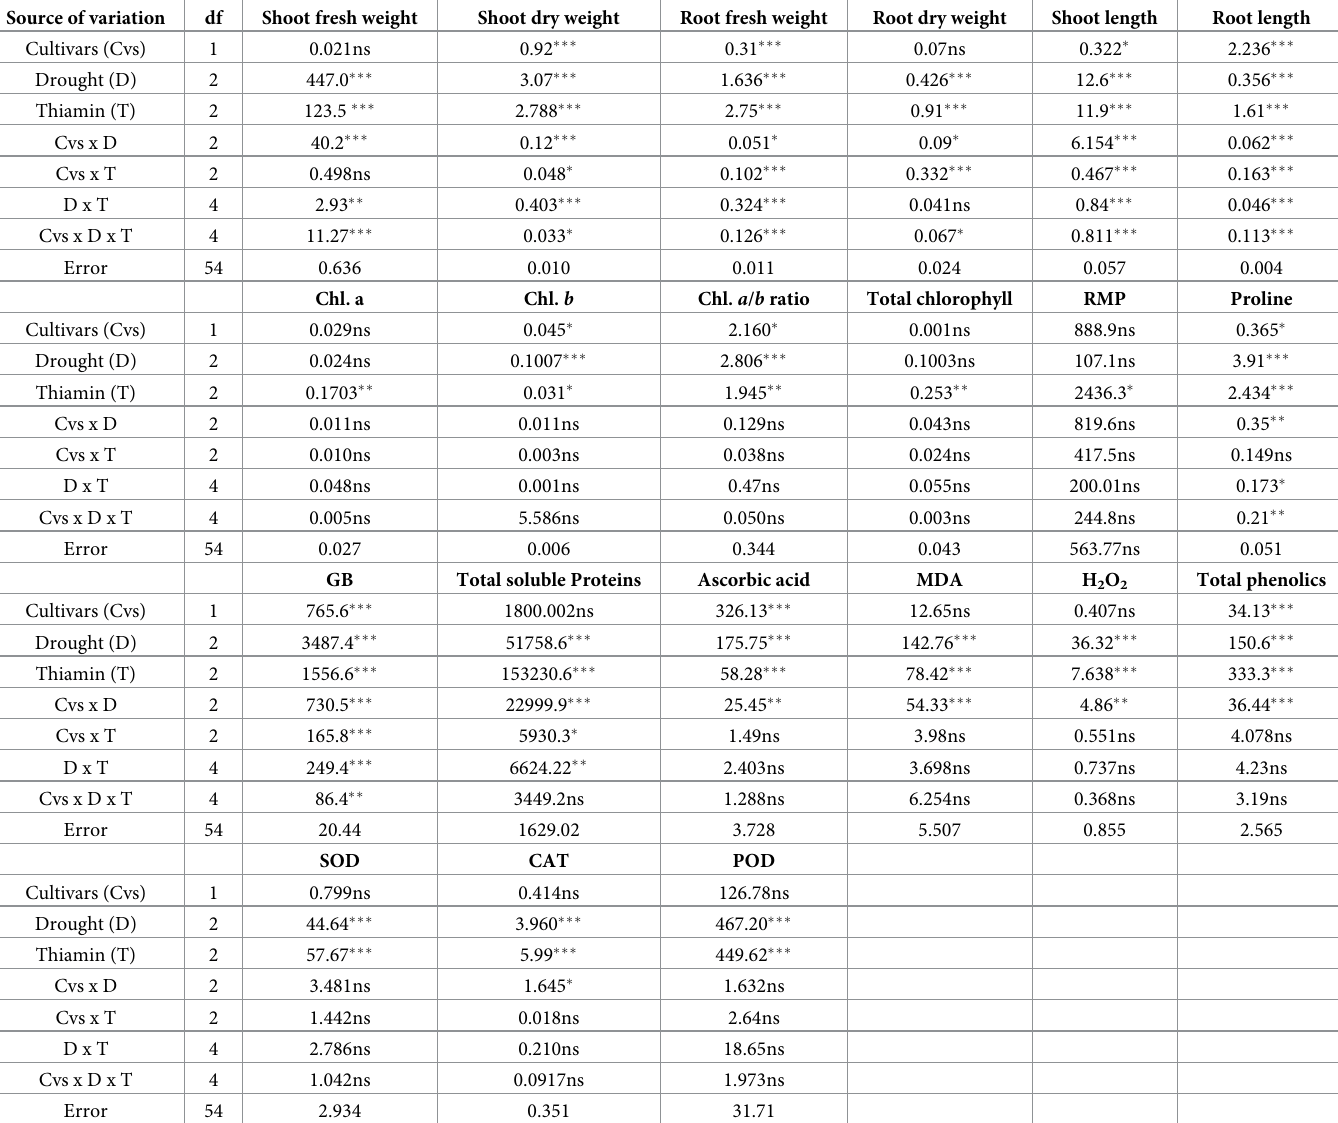
Table 1. Mean square values for growth and leaf biochemical characteristics of cauliflower ( Brassica oleracea L.) plants treated with thiamin subjected to water defi- cit